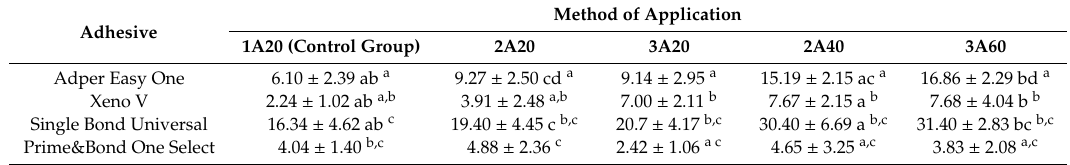
Table 4. Shear bond strength (MPa) (mean values ± standard deviation) of the tested adhesives. Adhesive